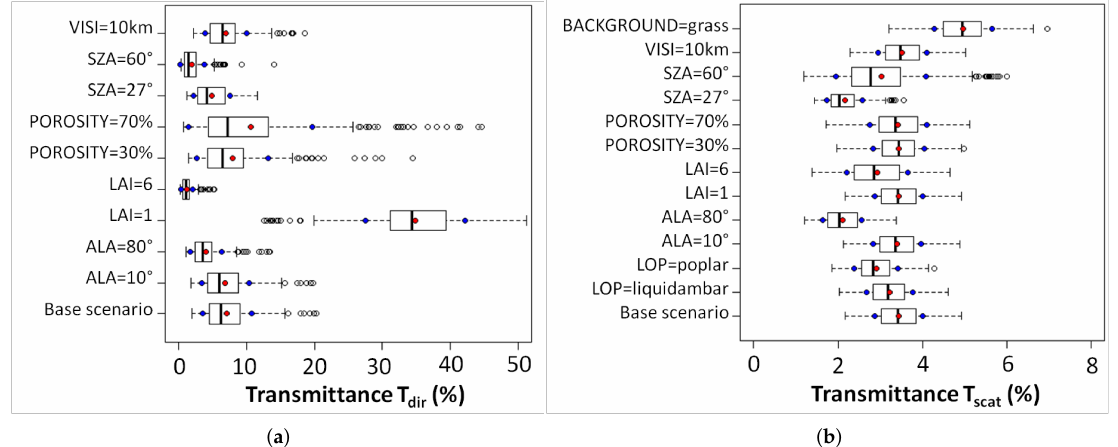
Figure 2. This is a wide figure. Figure 13. Boxplots of ( a ) T dir and ( b ) T scat representing their spatial variations computed within the tree shadow delineations at ground for the empirical tree model at 0.8 µ m with the variations of the input parameters compared to the base simulation scenario (red/blue dots: mean/standard